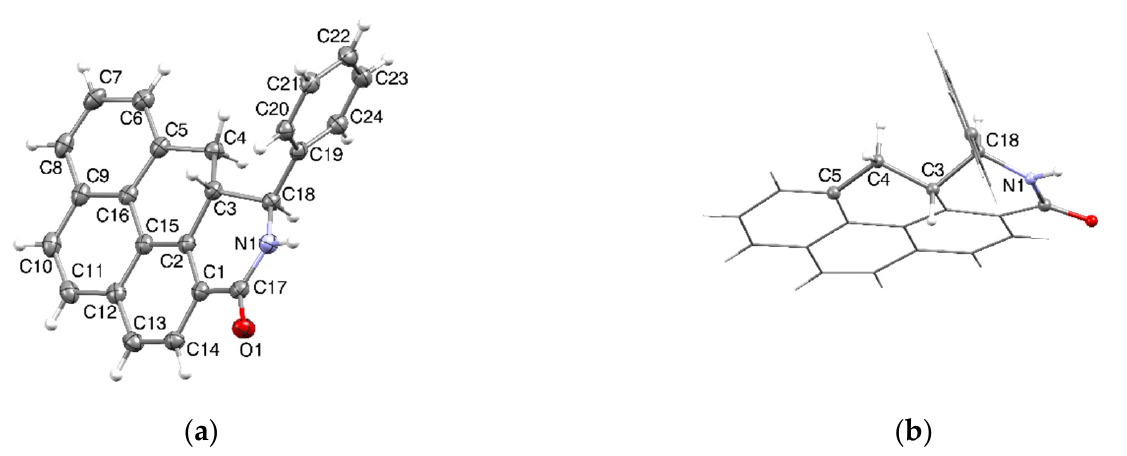
Figure 1. ( a ) Compound 6 in ORTEP representation, with atomic displacement parameters at 50% probability level; H atom labels omitted for clarity; ( b ) highlighted molecular conformation and the trans ( e,e )-junction of the non-aromatic rings with axial hydrogens at the stereogenic carbon atoms C3 and C4; phenyl ring projecting from the image plane towards the observer.